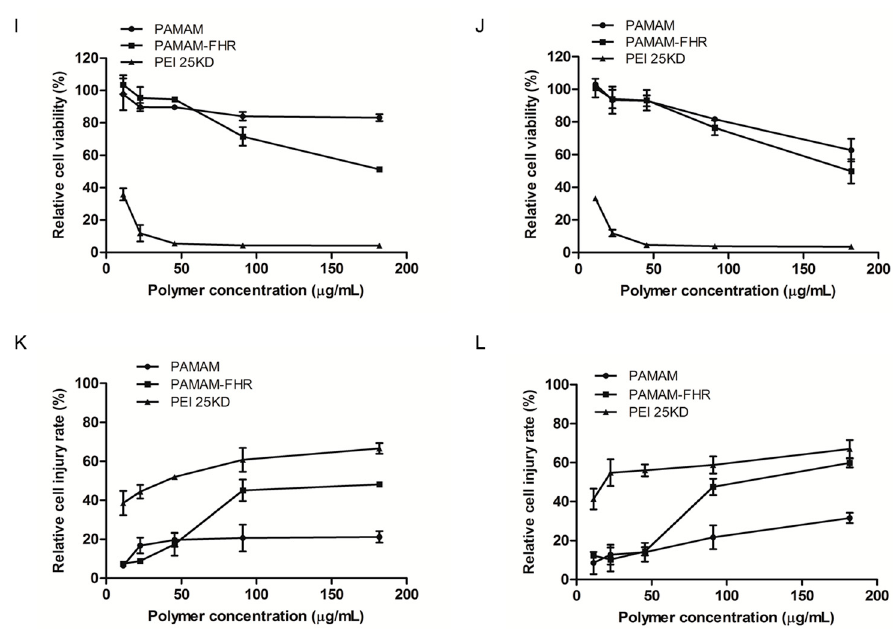
Figure 2. In vitro cytotoxicity assay in PAMAM-FHR-treated cells. ( A , B ) GBL-14, ( E , F ) U373-MG, and ( I , J ) dermal fibroblasts were incubated with different concentrations of the polymers for 24 h ( A , E , I ) and 48 h ( B , F , J ). Cytotoxicity was assessed using a WST-1 assay. Results are shown as the mean ± standard deviation, n = 3. ( C , D ) GBL-14, ( G , H ) U373-MG, and ( K , L ) dermal fibroblasts incubated under the same conditions as those used for the WST-1 assay. Cell viability was assessed by the lactate dehydrogenase (LDH) assay. After 24 h ( C , G , K ) and 48 h ( D , H , L ). Results are shown as the mean ± standard deviation, n = 3.